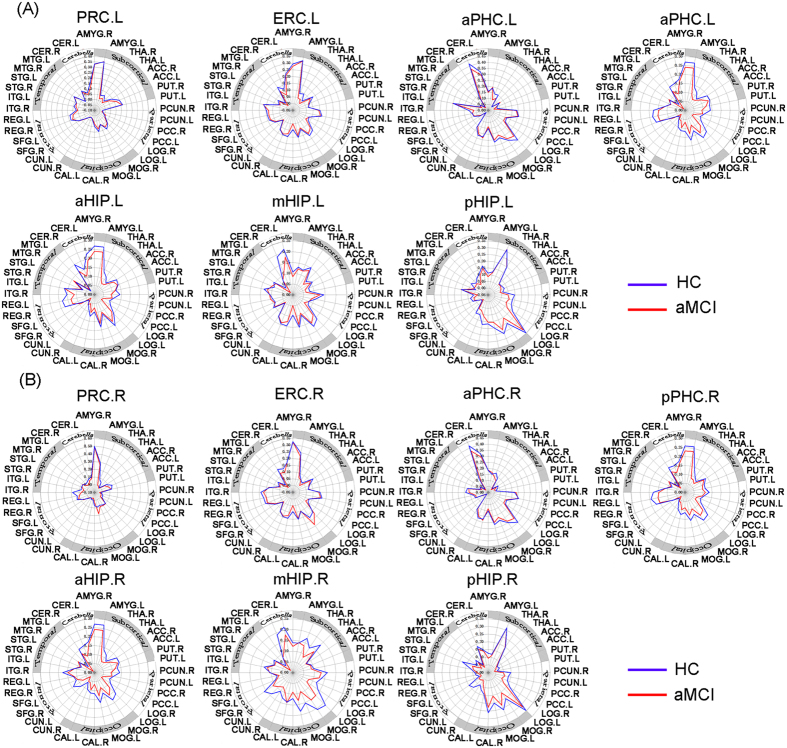
Heterogeneous functional connectivity associated with distinct parahippocampal and hippocampal seeds in HC and aMCI subjects ((A) left hemisphere seeds; (B) right hemisphere seeds). Schematic polar plot depicts connectivity patterns of four parahippocampal and three hippocampal seeds with target ROIs distributed across the whole brain. The concentric circles depict parameter estimates representing the connectivity strength. Note that the data of functional connectivity are extracted from the only brain regions corresponding to Fig. S1. Abbreviation: AMYG, amygdala; THA, thalamus; ACC, anterior cingulate gyrus; PUT, putamen; PCUN, precuneus; PCC, posterior cingulate cortex; LOG, inferior occipital gyrus; MOG, middle occipital gyrus; CAL, calcarine gyrus; CUN, cuneus; SFG, superior frontal gyrus; REG, rectus gyrus; ITG, inferior temporal gyrus; STG, superior temporal gyrus; MTG, middle temporal gyrus; CER, cerebelum.